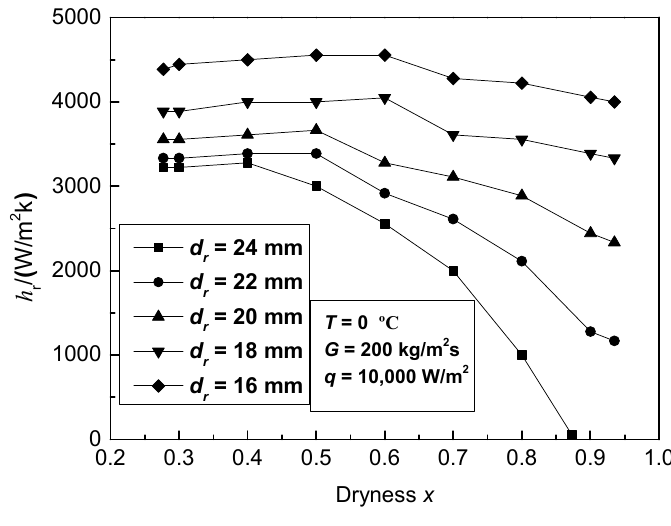
Figure 11. Effect of d r on h r . Figure 11. E ff ect of d r on h r .